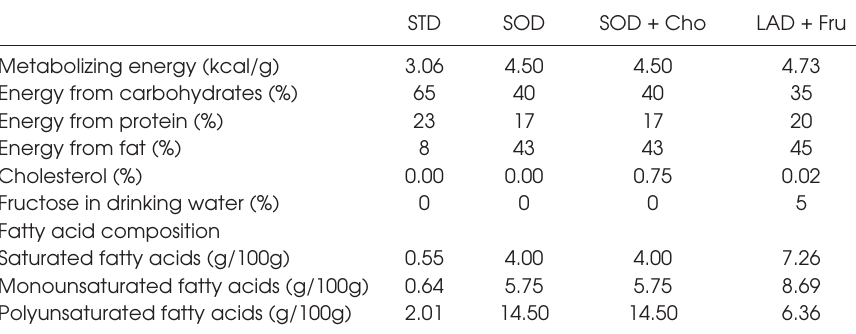
Table 1. Composition of mouse diets used in the feeding